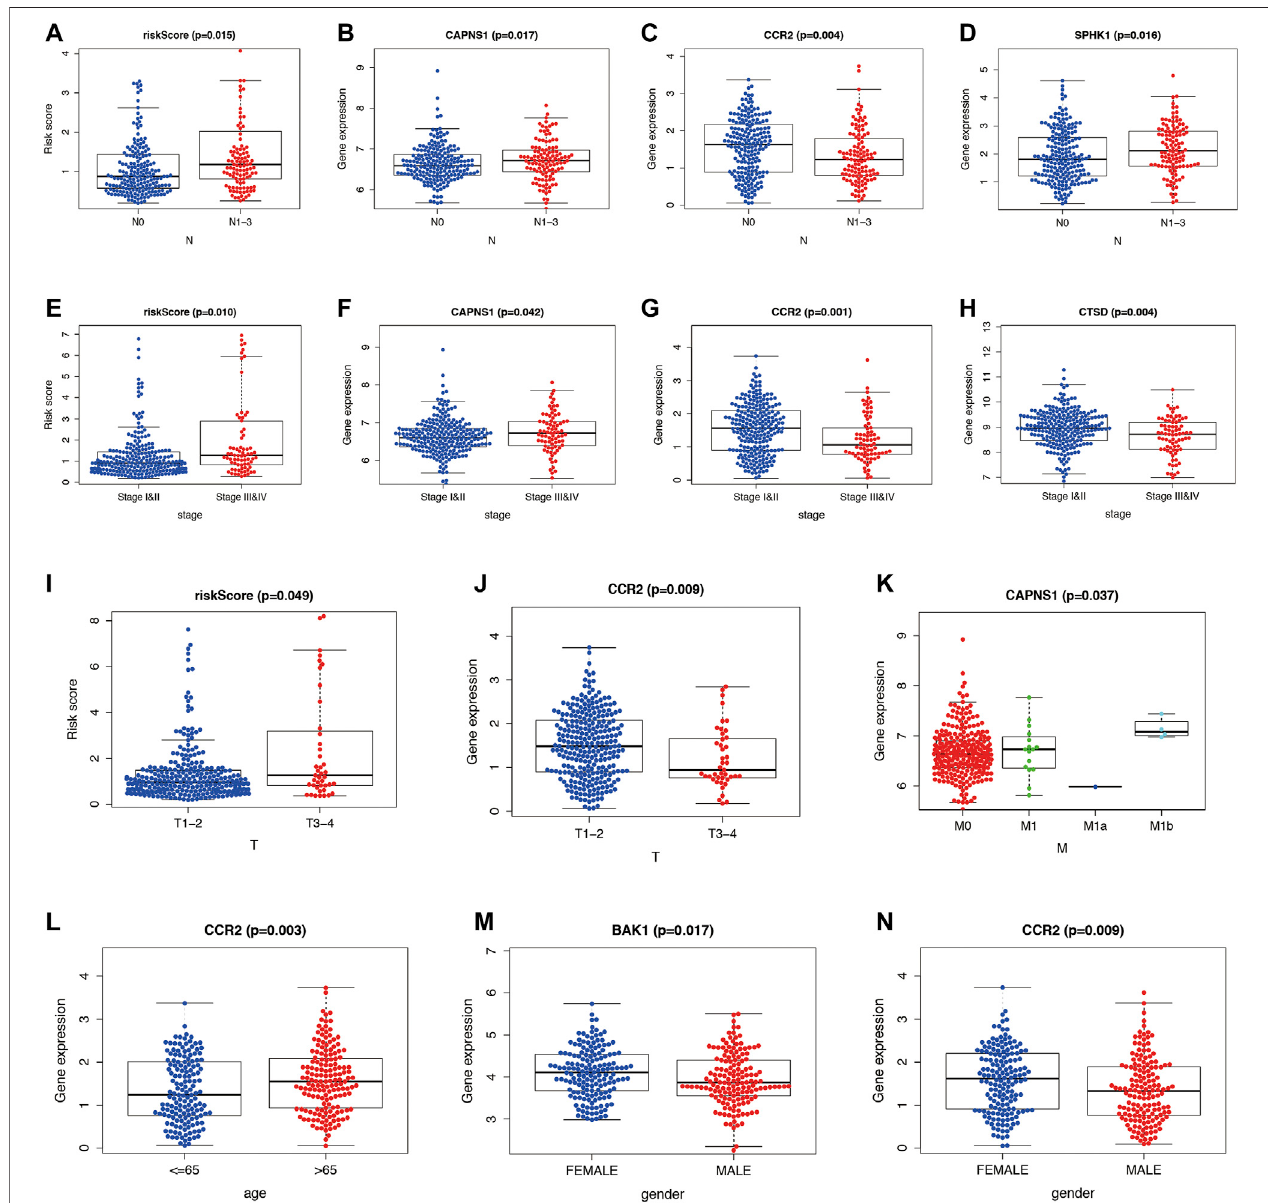
FIGURE 10 | Comparison of ARGs and clinicopathological variables in LUAD. (A – D) Difference in the risk score and expression levels of ARGs between pathological N0 stage and pathological N1 – N3 stages. (E – H) Difference in the risk score and expression levels of ARGs in stage I and II and stage III and IV. (I,J) Difference in the risk score and expression levels of ARGs in pathological T3 – T4 stage and pathological T1 – T2 stage. (K) Difference in the expression levels of ARGs in pathological M0 and M1 stage. (L) Difference in the expression levels of ARGs in aged ≤ 65 and > 65 years. (M,N) Difference in the expression levels of ARGs in gender (male and female). ARGs, autophagy-related genes; LUAD, lung adenocarcinoma.